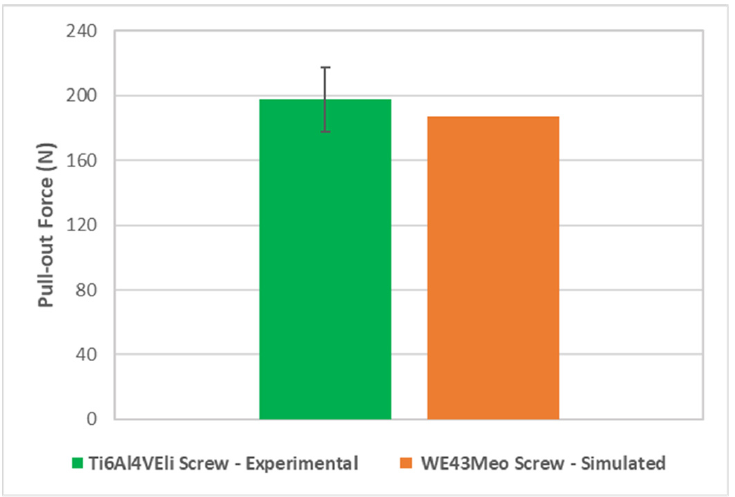
Figure 14. Comparative pull-out strength—experimental results for a screw made of titanium alloy Ti6Al4VEli and the simulated results. In the case of experimental data, n = 5.